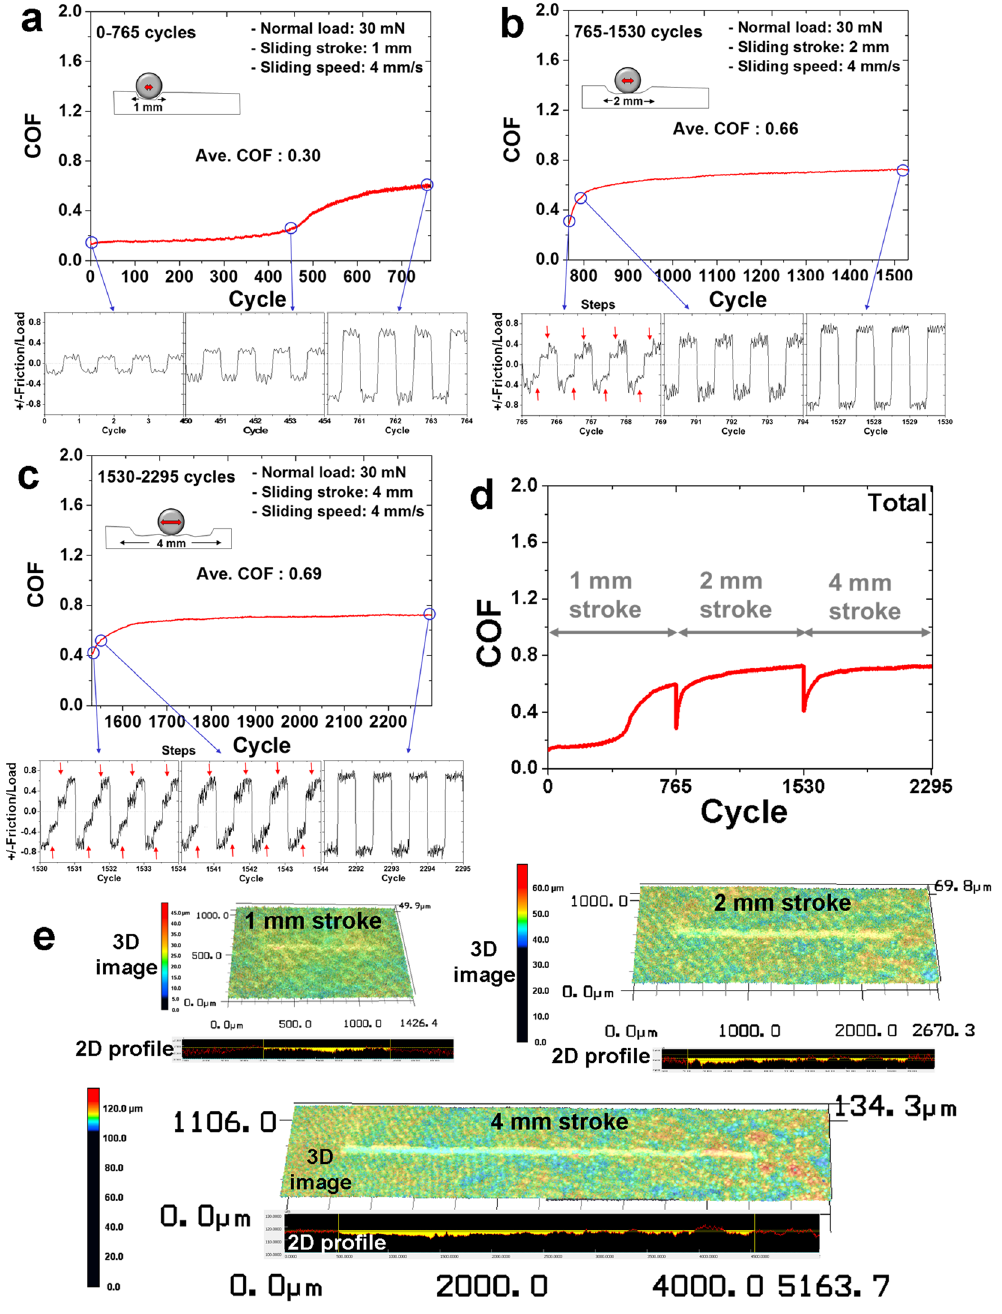
Figure 3. Variation of friction and wear characteristics of dehydrated hydrogel coating with respect to the sliding stroke length. Average COF and ( ± ) friction/load of hydrogel coating as a function of the number of sliding cycles for stroke lengths of ( a ) 1 mm, ( b ) 2 mm, and ( c ) 4 mm. ( d ) Total average COF of the hydrogel coating over 2295 cycles. ( e ) Confocal microscope 2D/3D profile images of wear track with respect to the sliding stroke length. Red arrows indicate the different steps of the friction force signal during the